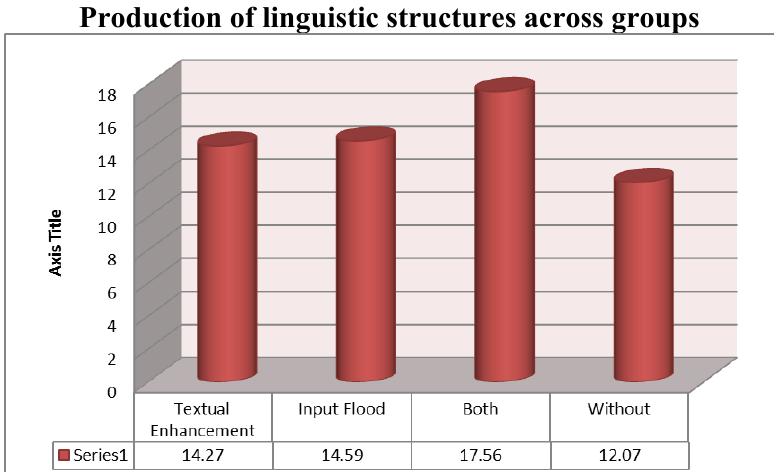
Production of linguistic structures across